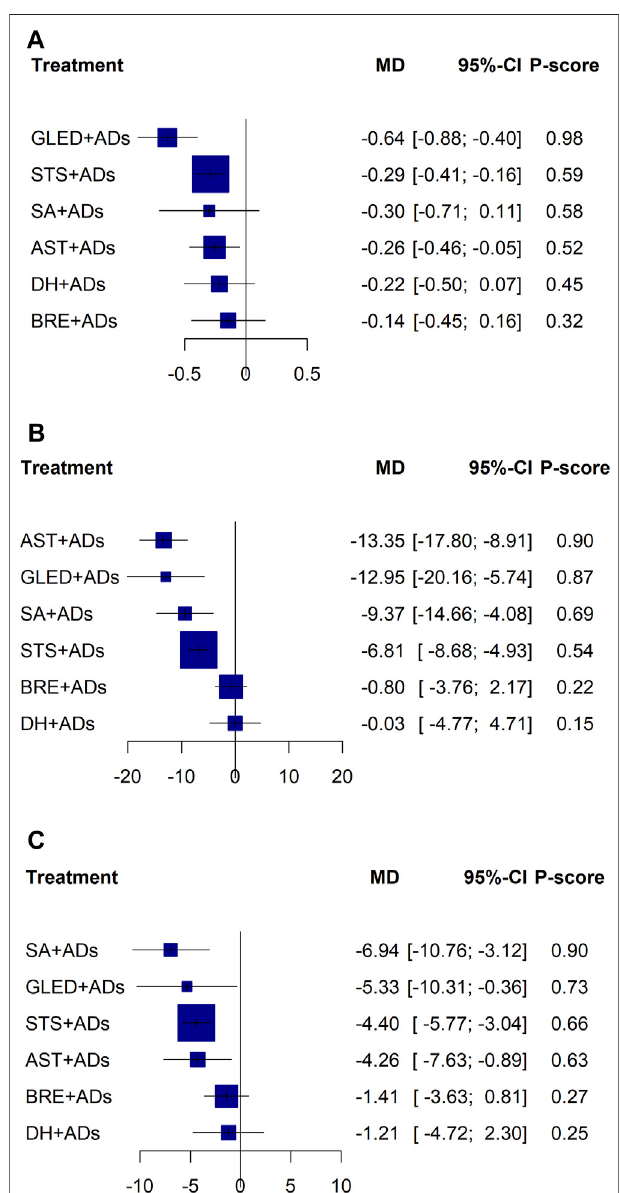
FIGURE 4 | Sensitivity forest plots for primary outcomes. ADs: antihypertensive drugs; SA: salvianolate; DH: danhong; BRE: breviscapine; AST: astragalus; STS: sodium tanshinone IIA sulfonate; GLED: ginkgo leaf extract and dipyridamole. (A) : 24-h urinary protein excretion; (B) : Systolic blood pressure; (C) : Diastolic blood